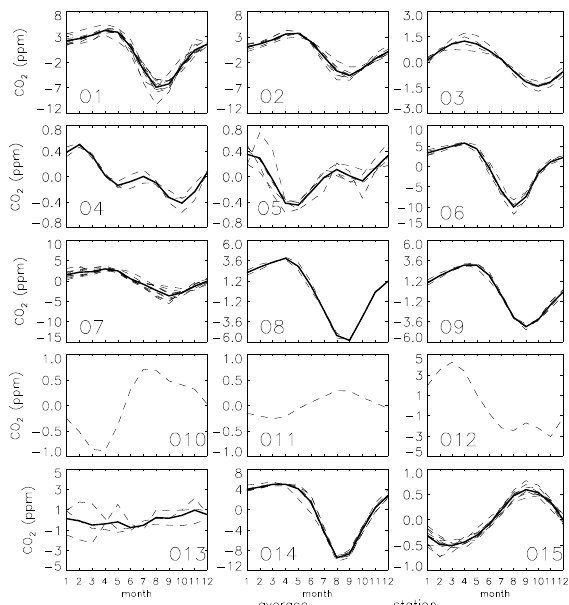
Fig. 6. Seasonal cycles of observational stations of 15 ocean groups 17 in ocean regions (15 regions are shown in Fig. 4. Broken line de- notes the seasonal values for all stations in one region; solid line denotes the regional averaged value of each region). The stations within the region northeast Pacific (O1) are labeled with “O1” in the “group” columns of Table A1. The way to find the stations in other regions is